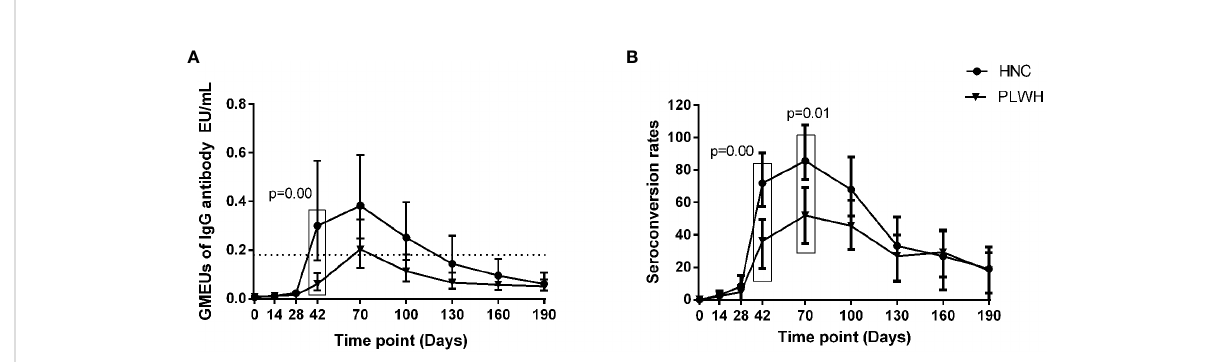
FIGURE 3 IgG antibody responses to vaccination with inactivated COVID-19 vaccine in PLWH and HNC. Titers (A) and seroconversion rates (B) of IgG at days 0-190 after vaccination. The threshold for a positive response is shown by the hashed line at 0.18EU/mL. Data points are medians (error bars represent 95% CI). P value calculated using Mann – Whitney U test (A) or Fisher ’ s exact test (B)